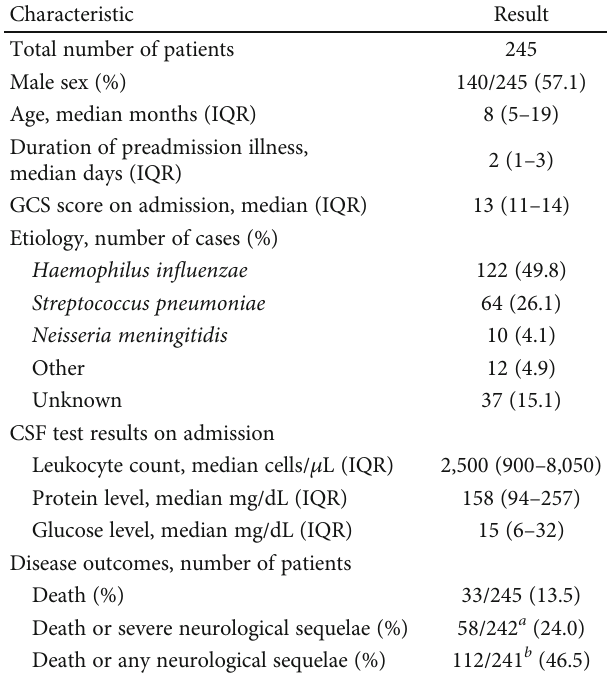
Table 1: Patient characteristics.